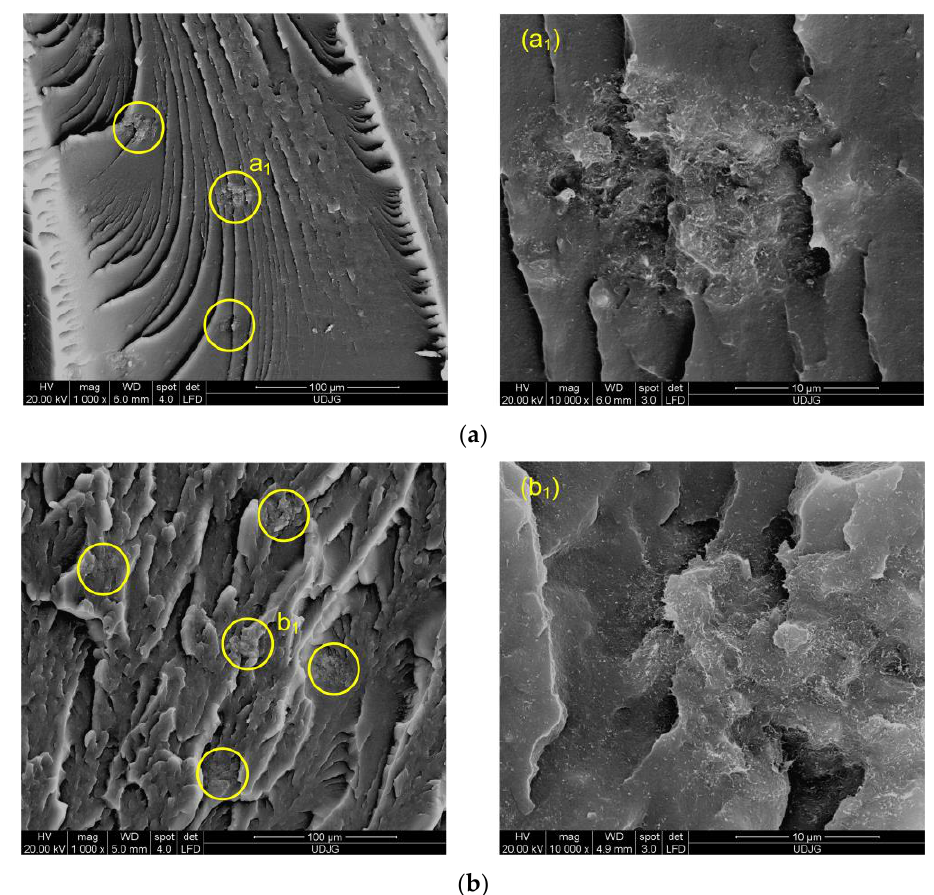
Figure 9. SEM micrographs for fractured surface of the EVA / MWCNT composite with ( a ) 1 wt.% and ( b ) 5 wt.% of MWCNTs (The yellow circles are spherical-like agglomerates).